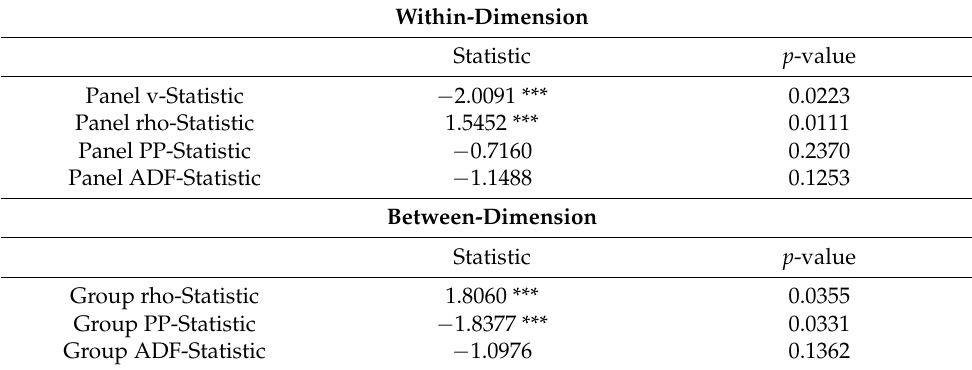
Table 5. Pedroni Cointegration test